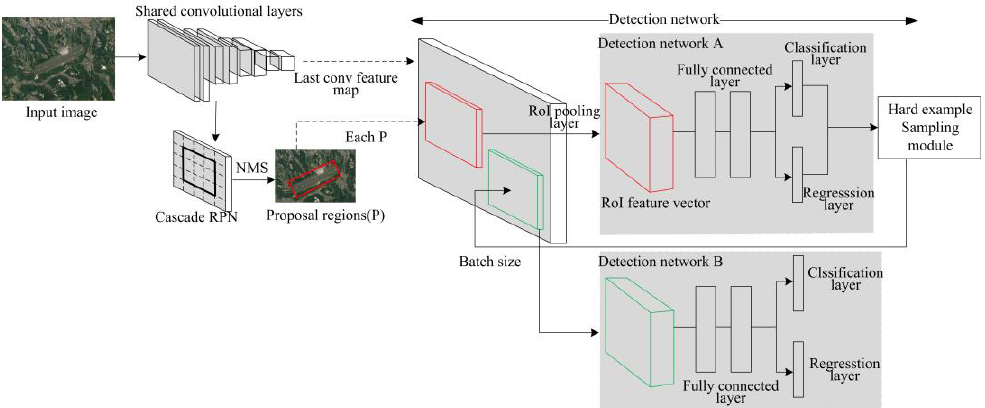
Figure 6. The overall structure of the method used in this study.